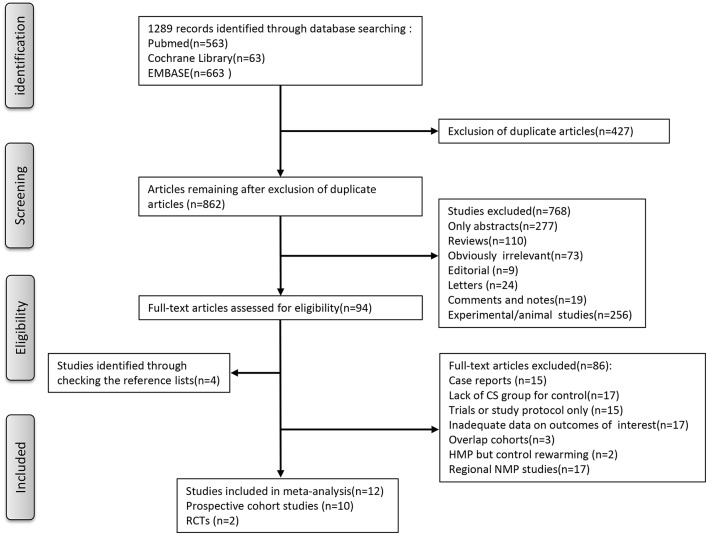
Flowchart showing search strategy with inclusions and exclusions.